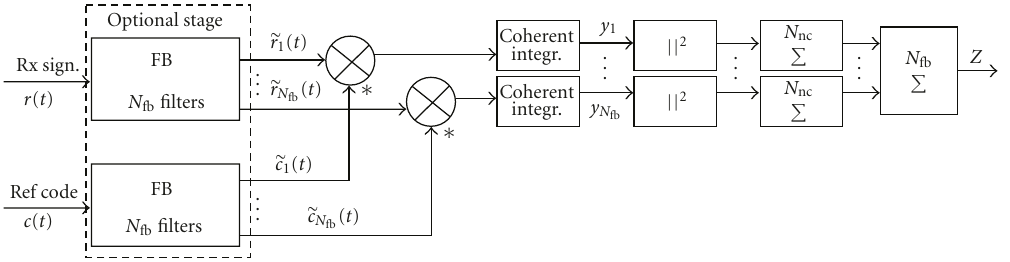
Figure 4: Block diagram of a generic acquisition